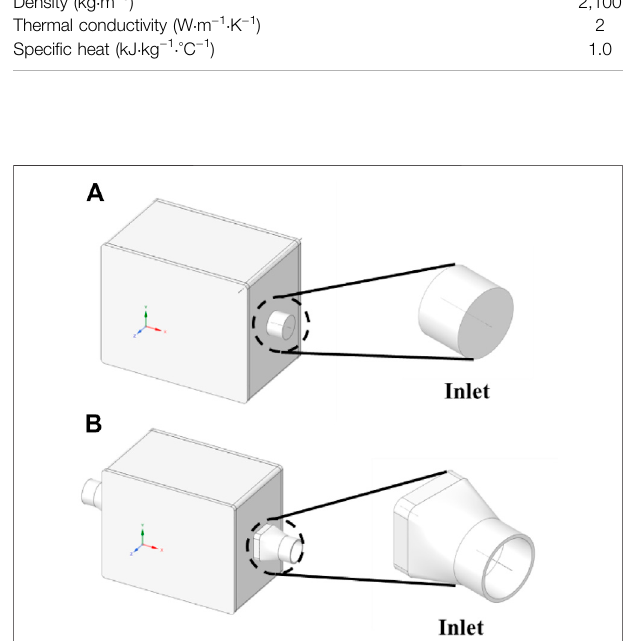
FIGURE3| Thestructureoftheinlet/outlet fl owchannel: (A) Structure1; (B) Structure 2.